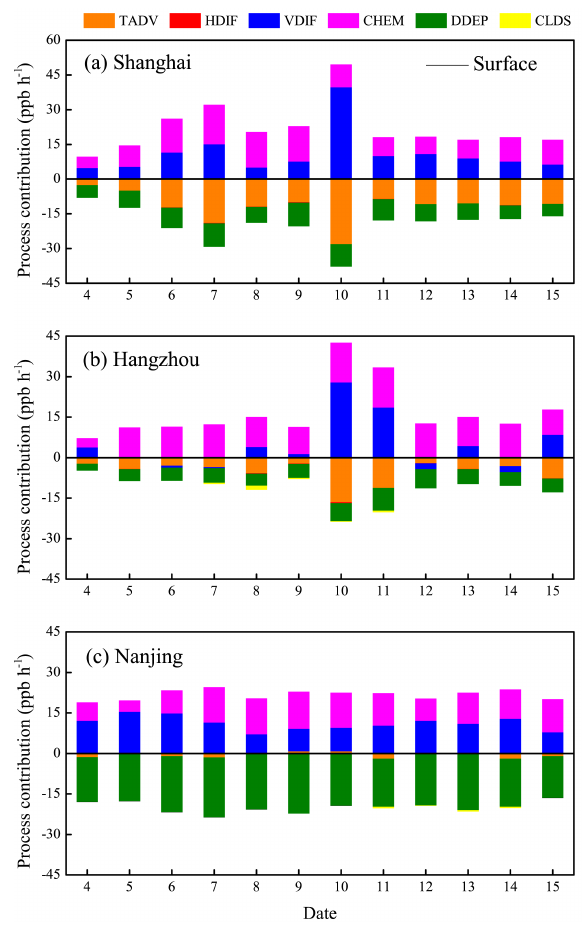
Figure 9. Variations of the daytime mean values for the contri- butions of individual processes to O 3 formation in (a) Shanghai, (b) Hangzhou and (c) Nanjing from 4 to 15 August 2013 at the sur- face layer. The contributors include the total advection (TADV), the horizontal diffusion (HDIF), the vertical diffusion (VDIF), the gas- phase chemistry (CHEM), the dry deposition (DDEP) and the cloud processes with the aqueous chemistry